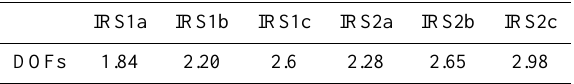
Figure 12. Impact of spectral resolution and radiometric noise on the CO retrieved profiles for cases IRS1a-IASI (red) and IRS2b (blue), compared with CO aircraft observation (in black). The left (right) plot corresponds to observation taken at Frankfurt airport on 6 January 2009 (26 May